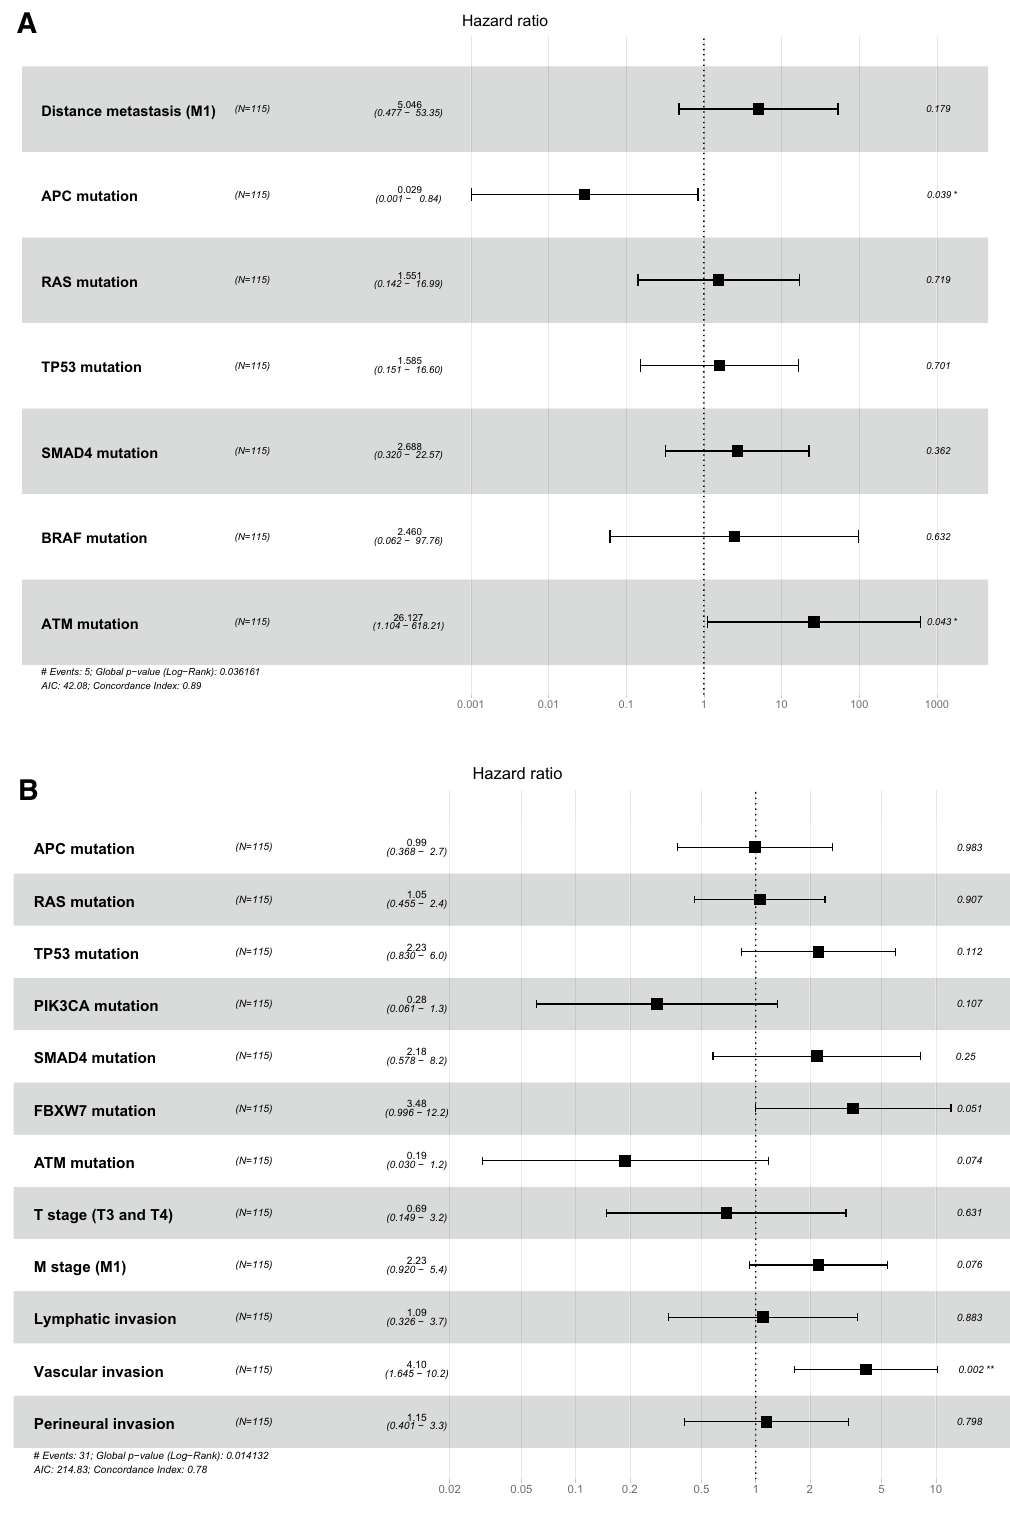
Figure 6. Forest plots for CRC prognostic markers. Multivariable Cox-proportional hazards analysis was performed to identify the prognostic markers that may predict OS ( A ) and DFS ( B ). Error bars represent hazard ratios and their 95% confidence